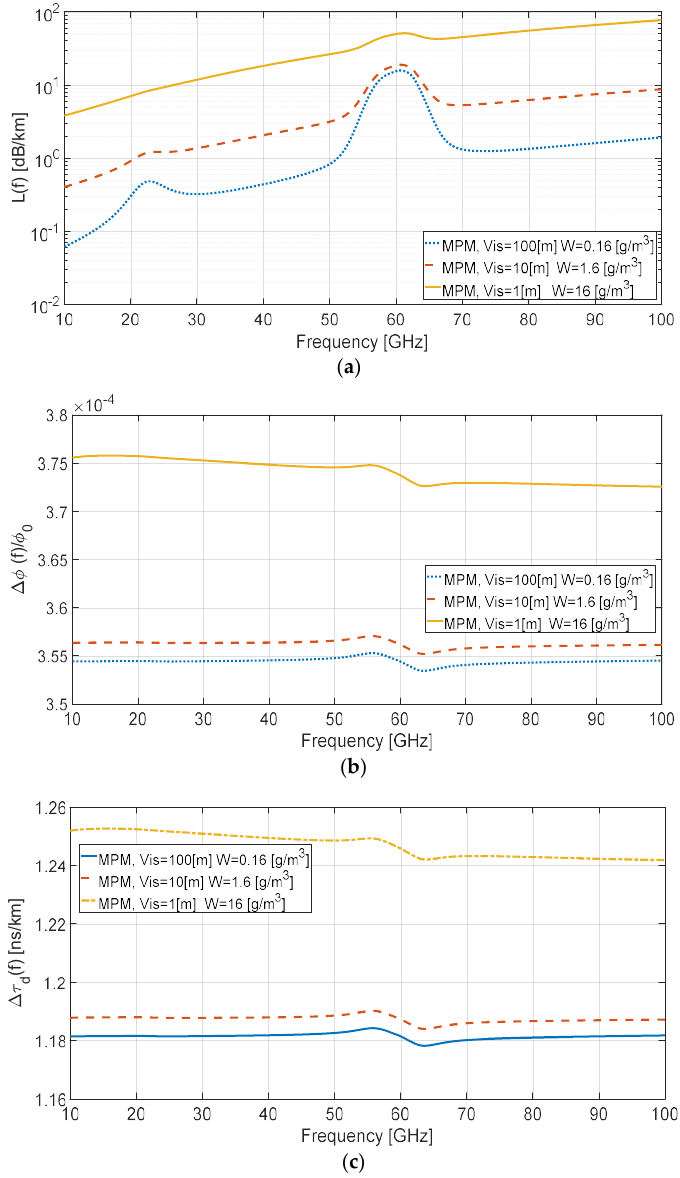
Figure 1. Transmission of millimeter waves in various fog visibilities in: ( a ) attenuation L ( f ) in [dB]; ( b ) incremental phase shift ∆ φ ( f ) / φ 0 ; ( c ) incremental group delay ∆ τ d ( f )